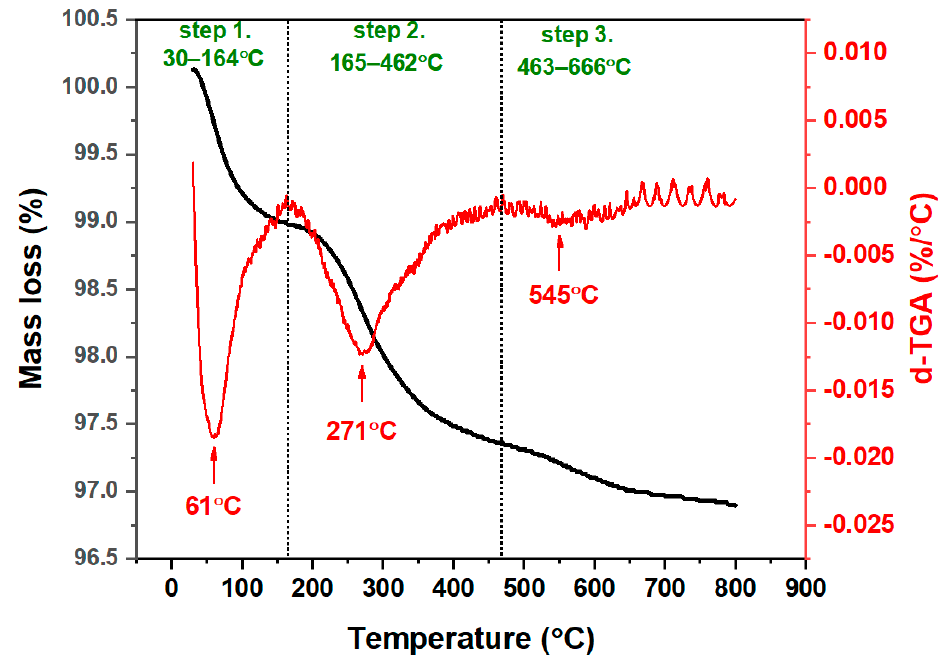
Figure 6. TGA and d-TGA curves of ZFNPs.